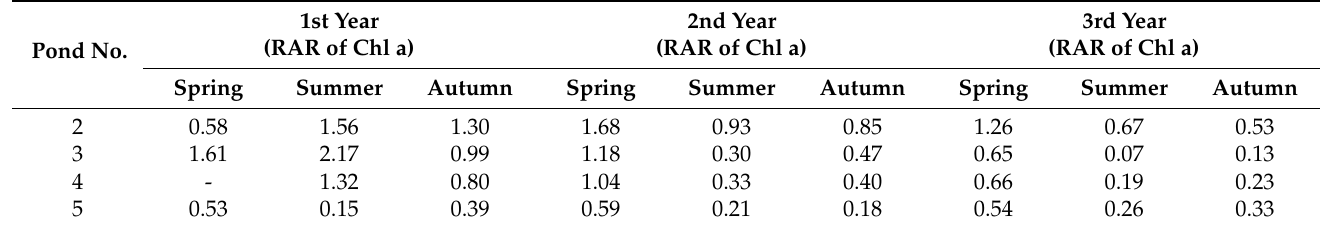
Table 6. Statistics of the RAR of the quarterly average Chl a value 1 at each